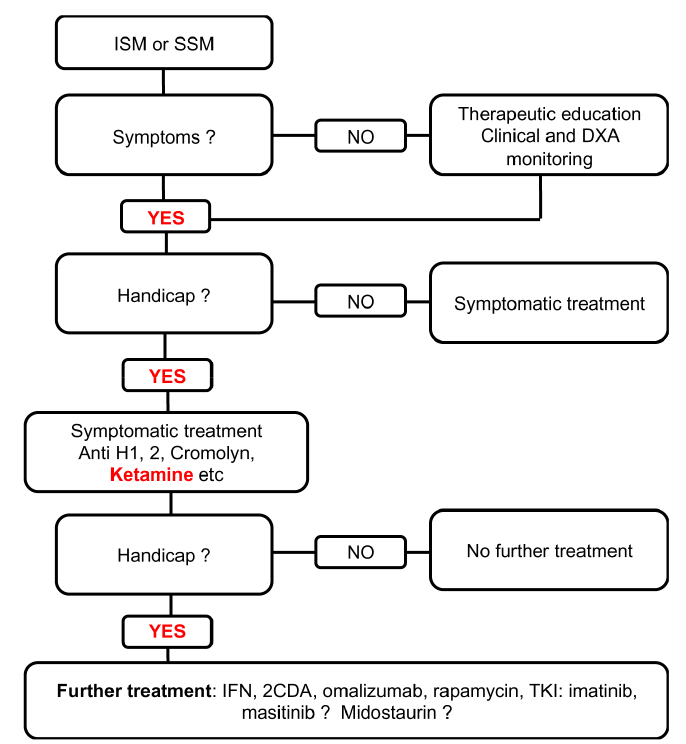
Figure 3. Treatment flow chart for indolent and smoldering systemic mastocytosis. 2CDA, cladribine; DXA, dual-energy X-ray absorptiometry; IFN, interferon; ISM, indolent systemic mastocytosis; SSM, smoldering mastocytosis; TKI, tyrosine kinase